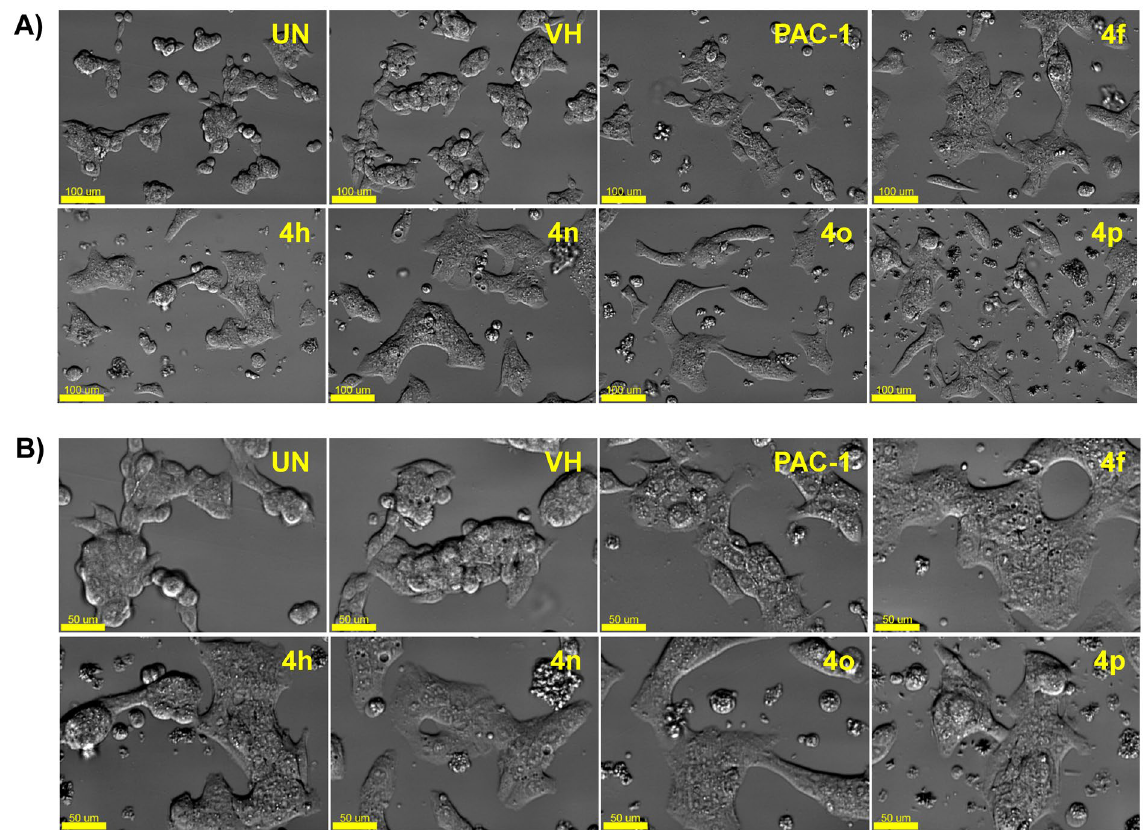
Figure 7. Morphology changes of cells treated with compound 4f, 4h , 4n, 4o , 4p or PAC-1. SW620 at 2.5 × 10 5 cells/mL (500 µL in 24 well) were incubated for 24 h and then further treated with compounds or PAC-1 (50 μM) for 24 h. Cells were photographed using an Imaging Device (Celldiscoverer 7) with ×20 ( A ) and ×40 ( B ) lens. Scale bar: 50 mm. UN untreated, VH vehicle (DMSO. 0.1%). Representative images are